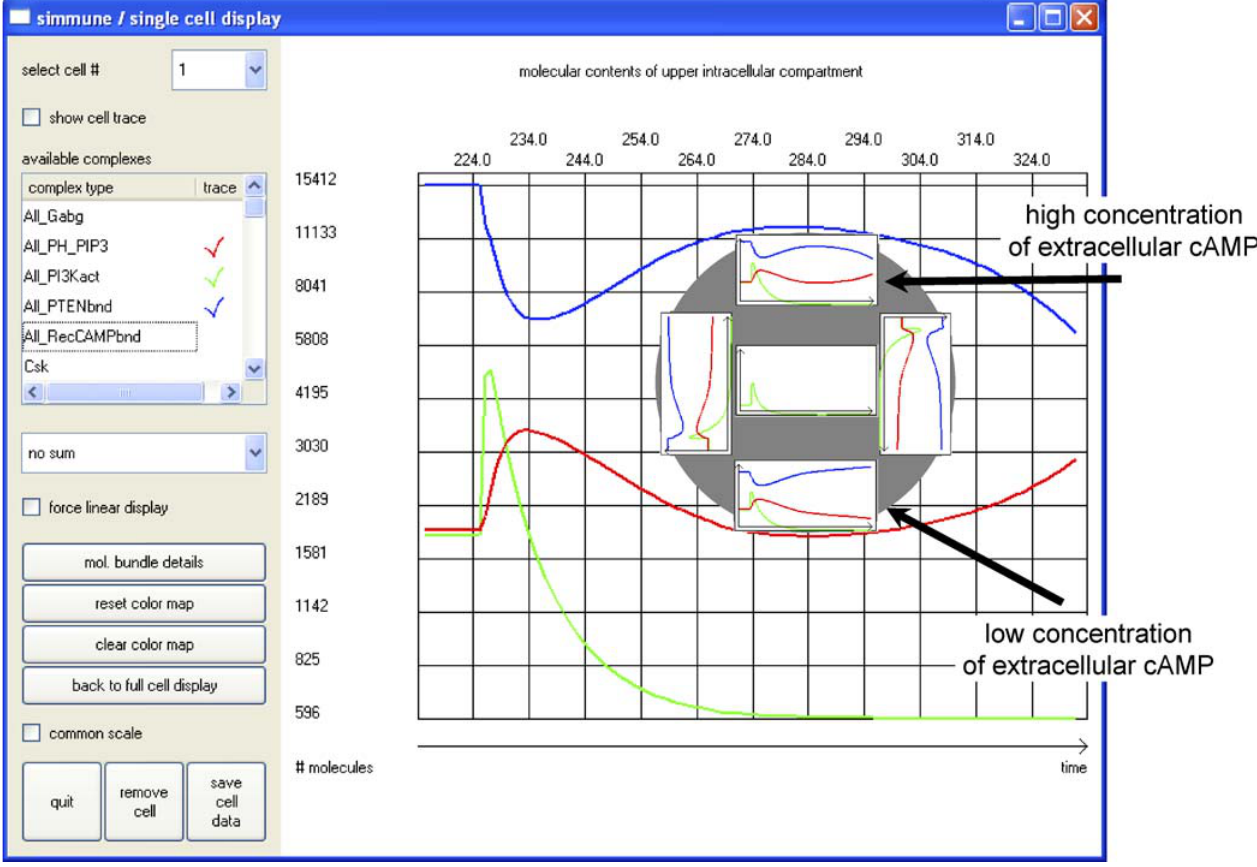
Figure 4. Comparison of the Simulated Activities of PI3K, Membrane-Bound PTEN, and the Resulting Behavior of PIP 3 (Composite Screenshot) Stimulation of a cell in a 2:1 cAMP gradient (mean concentration 500 nmol) leads to a rapid 3-fold increase in the membrane proximal activity of PI3K (green) and to a loss of membrane-bound PTEN (blue; tracked as GFP-PTEN in real cells). This results in a rapid accumulation of PIP 3 (red; reported by the location of PH-GFP in real cells). Subsequently, the PI3K activity is strongly quenched by the recruitment of regulatory components to the membrane and falls below its prestimulus level in less than 20 s. PTEN returns more slowly to the membrane. During the phase of downregulation of PI3K activity and reattachment of PTEN to the membrane, the concentration of PIP 3 decays. In the front of the cell (which experiences a high cAMP concentration), membrane-associated PTEN only returns to a fraction of its prestimulus level and then enters a second phase of decline. After approximately 50 s, the low level of membrane-bound PTEN that is reached in the front of the cell allows PIP 3 to increase again, even though the amount of active PI3K in this region is modest. In the back of the cell (low cAMP concentration), membrane-bound PTEN increases beyond its prestimulus level, resulting in a decrease of PIP 3 below its resting state concentration. The circular inset shows a two-dimensional representation of the dynamics of membrane-bound PTEN and PIP 3 in different regions of the three-dimensional simulation of a cell. DOI: